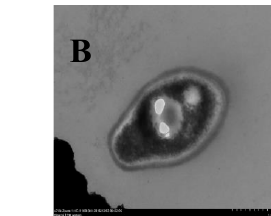
Table 1. Determination of the antioxidant capacity of the SCs and YL. Values are the means ± stand- ard error of three independent replicates.